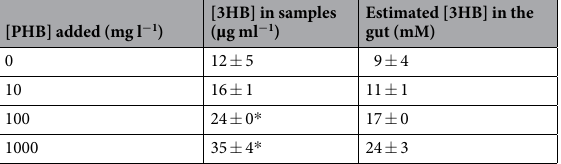
Table 1. Concentration of 3-hydroxybutyrate (3HB) in sterile brine shrimp ( Artemia franciscana ) samples that received different concentrations of poly-3-hydroxybutyrate (PHB) in the rearing water (average ± standard deviation of 3 replicates). The concentrations of 3HB in the brine shrimp gut were calculated as described in Materials and Methods. Asterisks indicate significantly higher concentrations than in the 0 mg l − 1 PHB treatment ( * : P < 0.05).